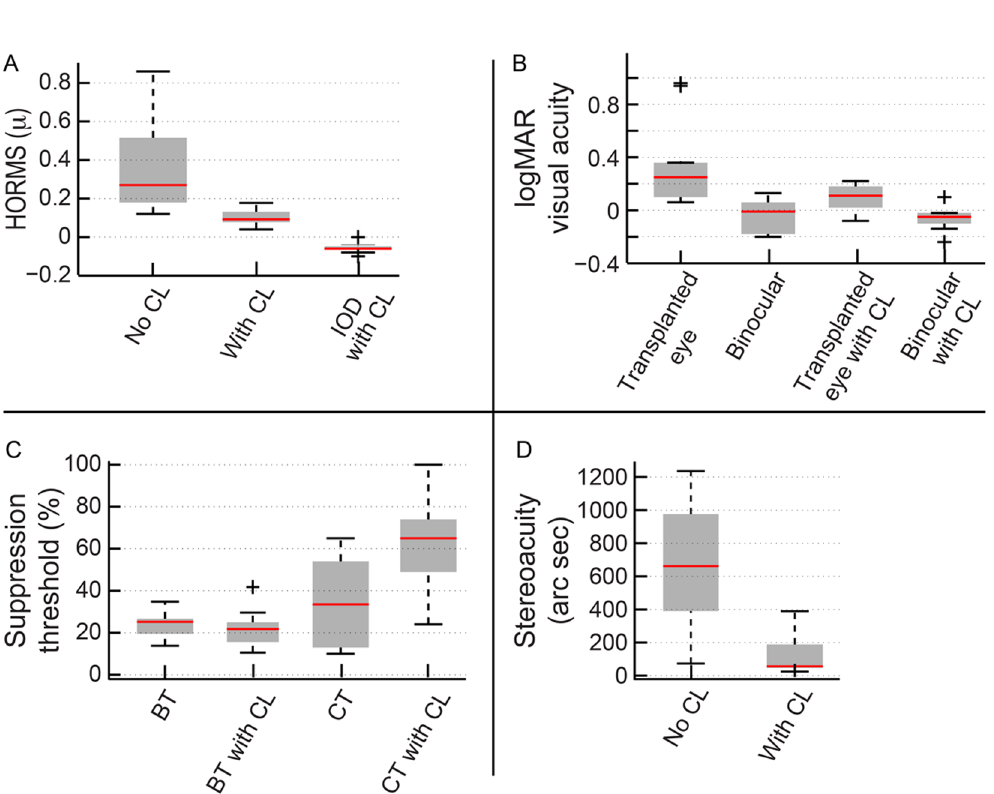
Fig 5. HORMS (panel A), high-contrast logMAR acuity (panel B), binocular thresholds (BT) and contrast thresholds (CT) (panel C) and stereoacuity (panel D) obtained with and without RGP contact lens in the second experiment of this study. Details of Box and Whisker plot same as Fig 1.